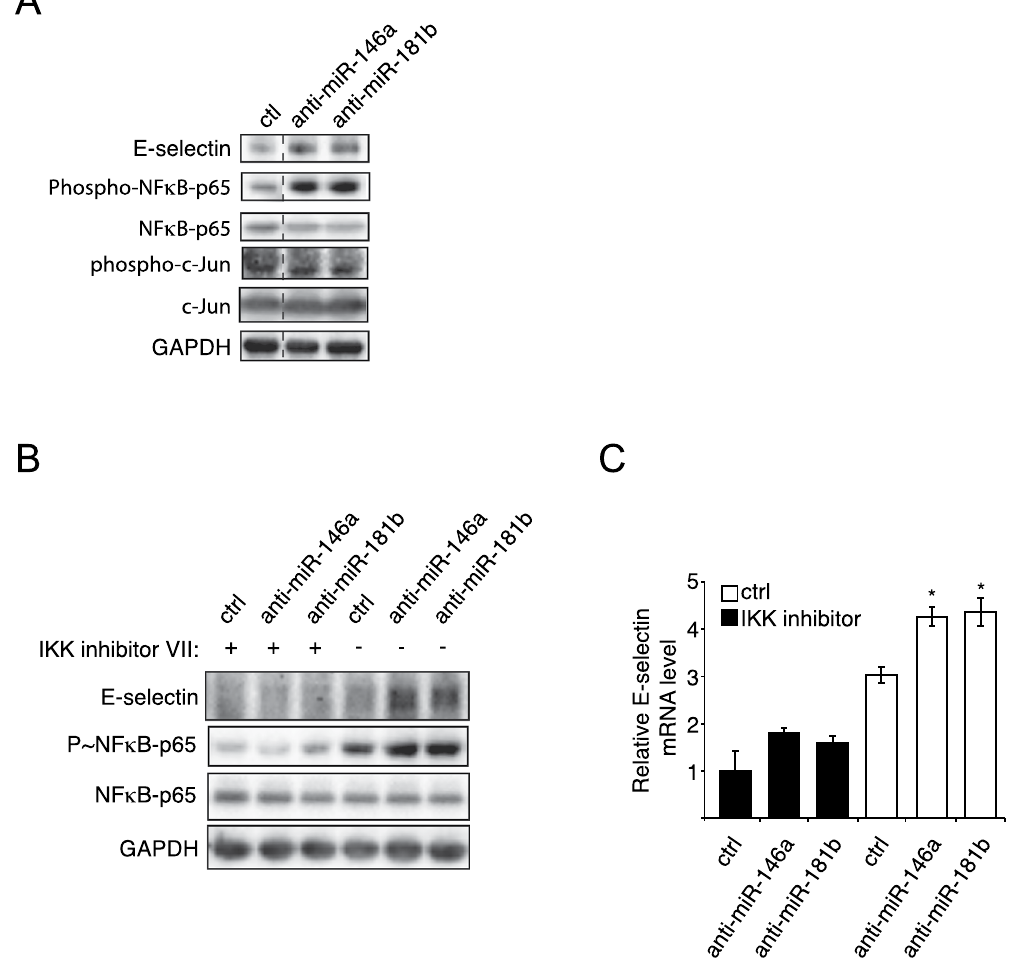
Figure 2. miR-146a and miR-181b repress the transcription of E-selectin by inhibiting NF- κ B signalling. ( A ). Endothelial cells were treated as in Fig. 1. The activities of NF- κ B and c-jun signalling pathways were monitored by Western blotting using anti-phospho-NFkB-p65 (S 536 ) and anti-phospho-c-Jun (S 63 ) antibodies. GAPDH was used as loading control. The dashed lines indicate that unrelated lanes have been removed between samples. See full-length blots in Supplementary Fig. S9. ( B , C ) Endothelial cells were transfected with 50 nM of miRNA inhibitors or control (ctrl), before being pretreated with 1 μ M IKK inhibitor VII, and being treated with IL-1 β (20ng/ml) for four hours. ( B ) The expression of E-selectin and the activity of NF- κ B signaling pathway were monitored by Western blotting. GAPDH was used as loading control. The Western blot is representative of three independent experiments. ( C ) RT-qPCR monitored the level of E-selectin mRNA. GAPDH mRNA was used as loading control. The quantification are the mean values of three independent experiments, the error bars represent standard errors of three independent experiments, and the significance was analyzed using a Student’s t-test. The p -values are calculated comparing to the “anti-miR ctrl/DMSO/IL-1 β ” group ( * p < 0.05; ** p <